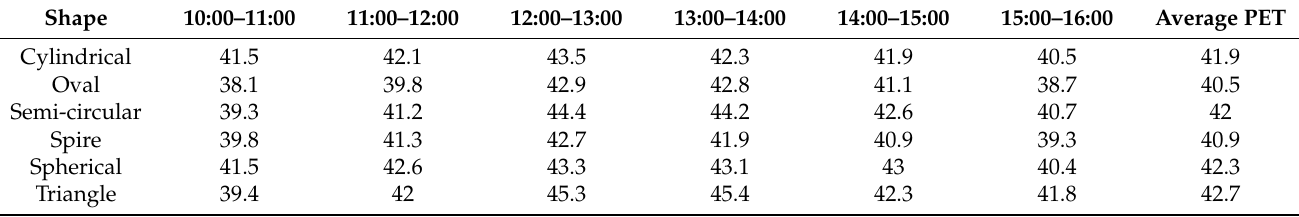
Table 4. Diurnal variation characteristics of PET in plants with different canopy geometries.